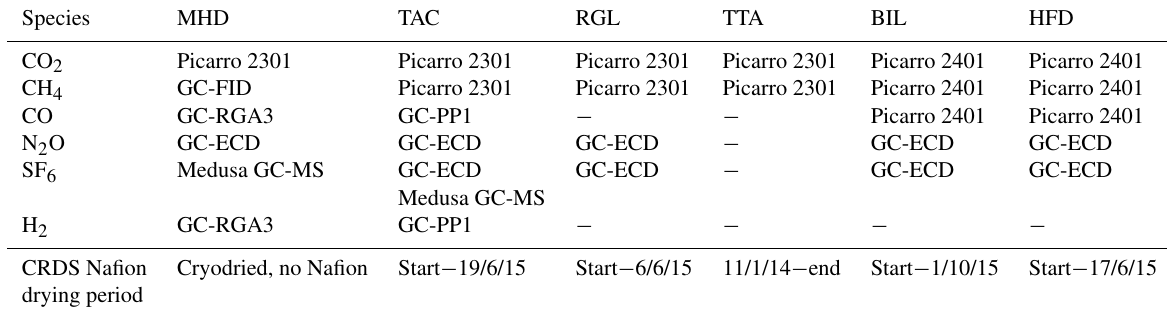
Table 2. Greenhouse gas and ozone-depleting substance species and instrumentation at each UK DECC site.